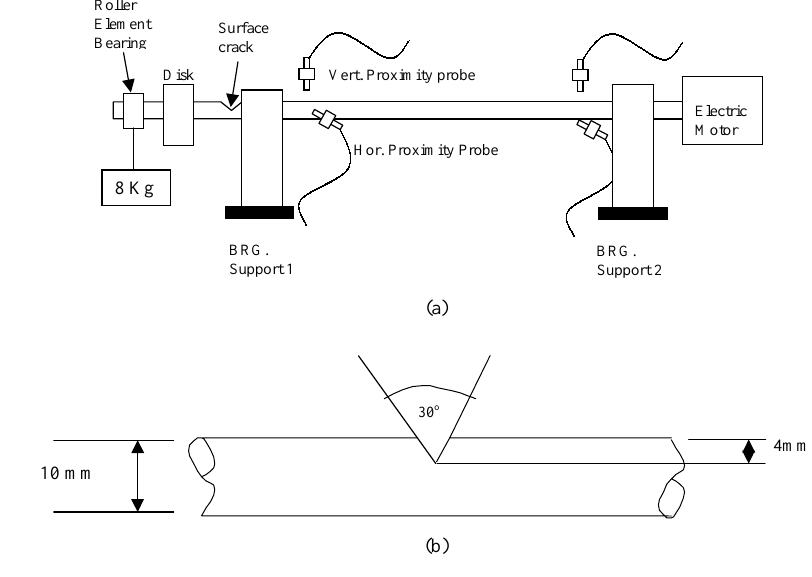
Fig. 1. Experiment rig. (a) Schematic diagram for Overhung rotor arrangement. (b) Crack geometry. Table 1 Summary of the experimental